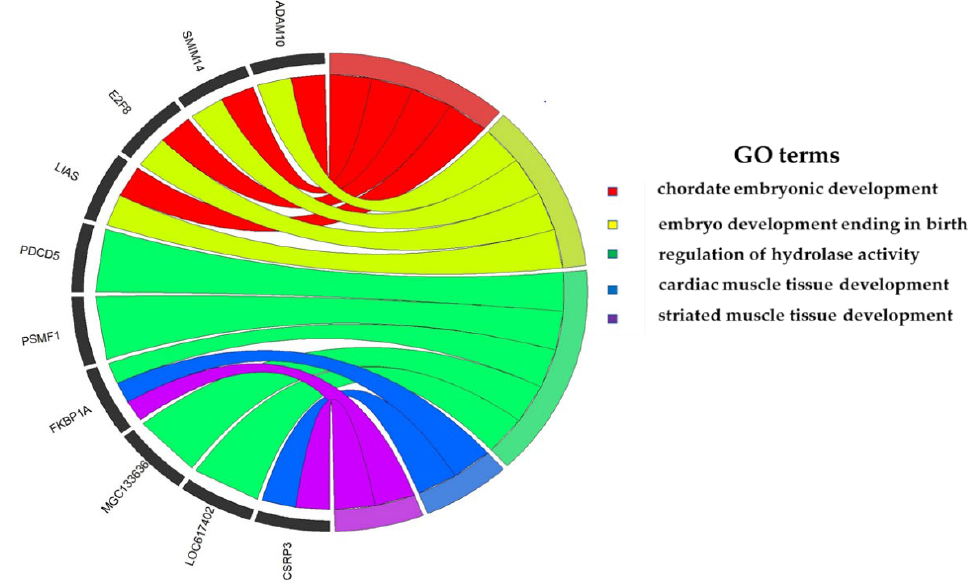
Figure 5. Gene Ontology term results from the udder conformation traits.